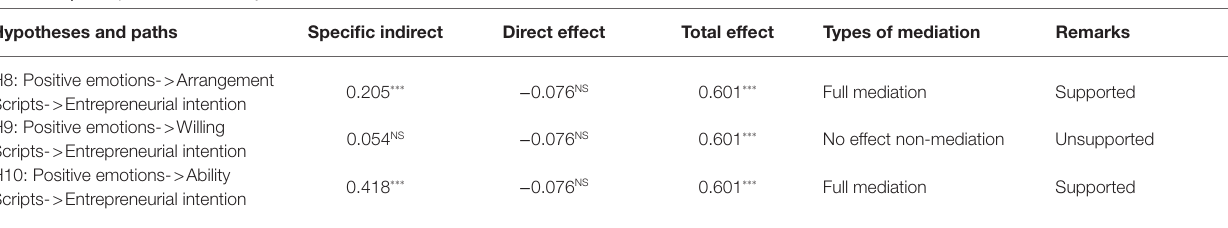
TABLE 9 | Multiple mediation analysis.